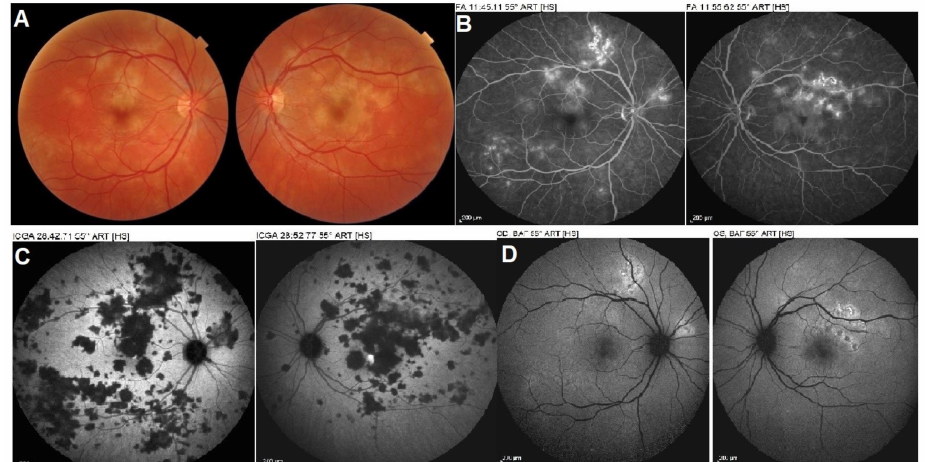
Figure 11. Multimodal imaging of APMPPE/AMIC. ( A ) Bilateral fundus pictures revealed whitish placoid lesions in the posterior pole and mid-periphery. ( B ) Same day late phase FA frames showed hyperfluorescence probably due to inner retinal vessel exudation. ( C ) ICGA late frames showed characteristic hypofluorescent patches, more widespread than the pathologic lesions seen on FA and BL-FAF ( D